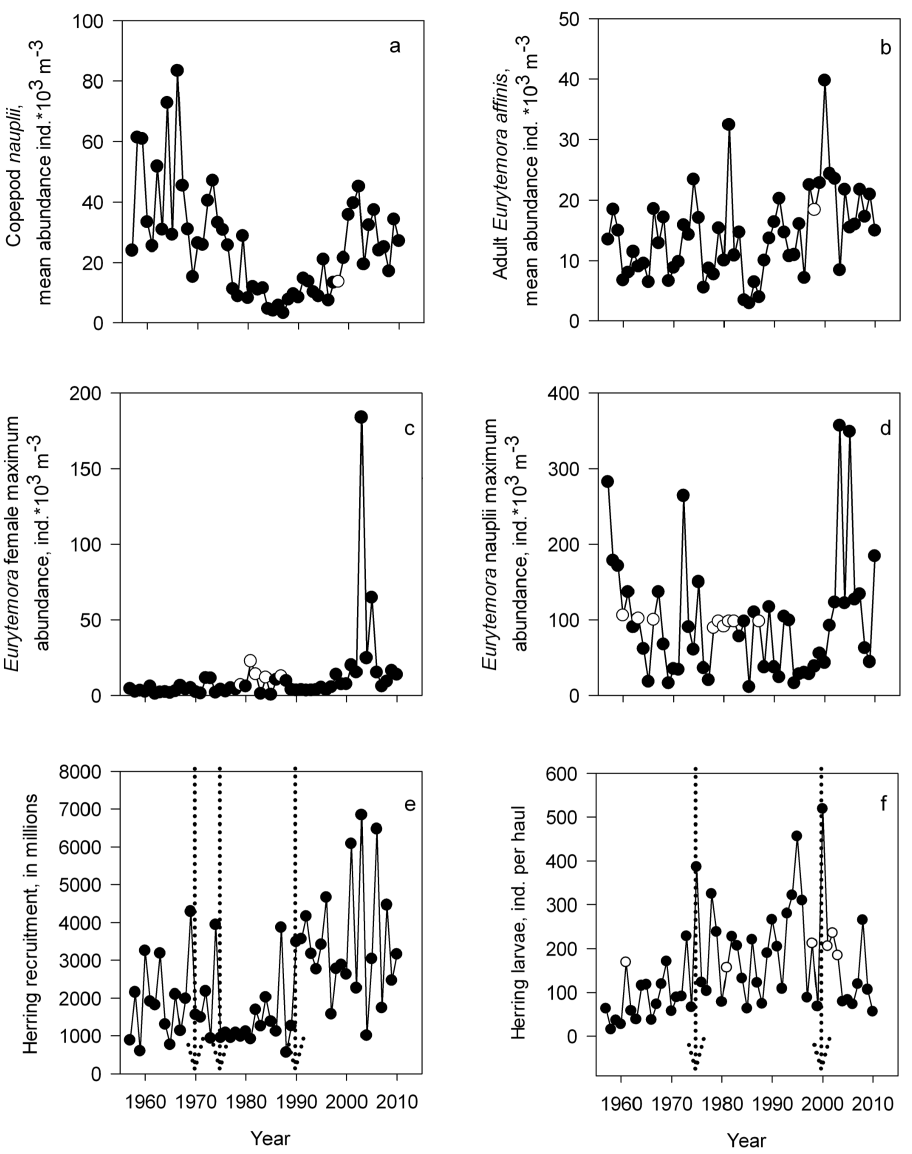
Figure 4. Long term dynamics of biotic variables as mean abundance of copepod nauplii (a), mean abundance of adult Eurytemora affinis (b), maximum abundance of female Eurytemora affinis and nauplii (c), number of herring recruitment (d), mean abundance of herring larvae (e). Dotted lines indicate the position of the shift detected in a single variables by shiftogram analyses. Empty dots denote the year when missing value replacement procedure was applied.